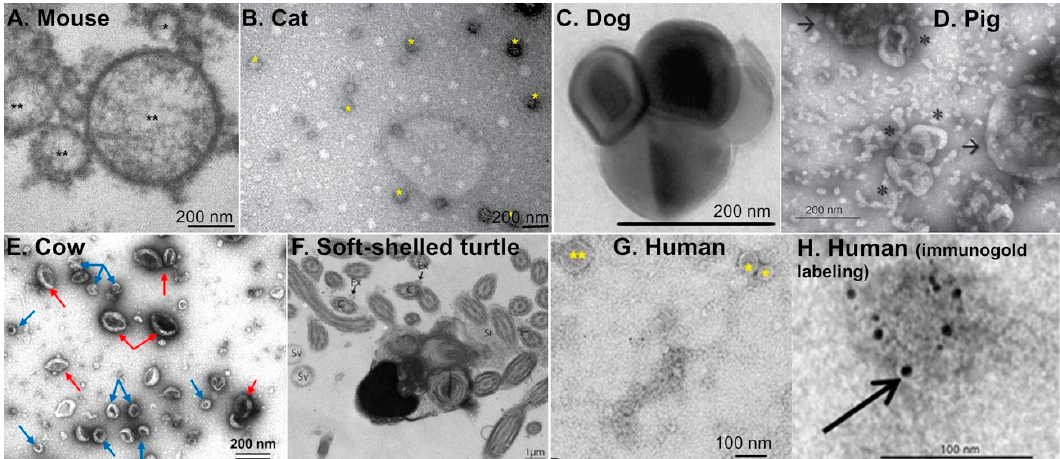
Figure 1. Transmission electron microscopy images of extracellular vesicles present in the oviductal fluid from different species, including rodents, domestic animals, farm animals, reptiles, and humans. ( A ) Mouse: exosome (*) and microvesicles (**). Reprint with permission from [23]. ( B ) Cat: extracellular vesicles (*). Reprint with permission from [28]. ( C ) Dog: oEVs. Reprint with permission from [25]. ( D ) Pig: exosomes (*) and microvesicles (arrows). Reprint with permission from [26]. ( E ) Cow: exosomes (blue arrows) and microvesicles (red arrows) isolated from in vivo oviduct. Reprint with permission from [24]. ( F ) Soft-shelled turtle: extracellular vesicles (arrows) in the lumen of the oviduct from the isthmus region. Reprint with permission from [27]. C; cilia, Ex; exosome, Sr; oviduct secretions, Sv; secretory vesicles. ( G , H ) Human: exosomes (*) and microvesicles (**) with or without immunogold labeling. Reprint with permission from [19].